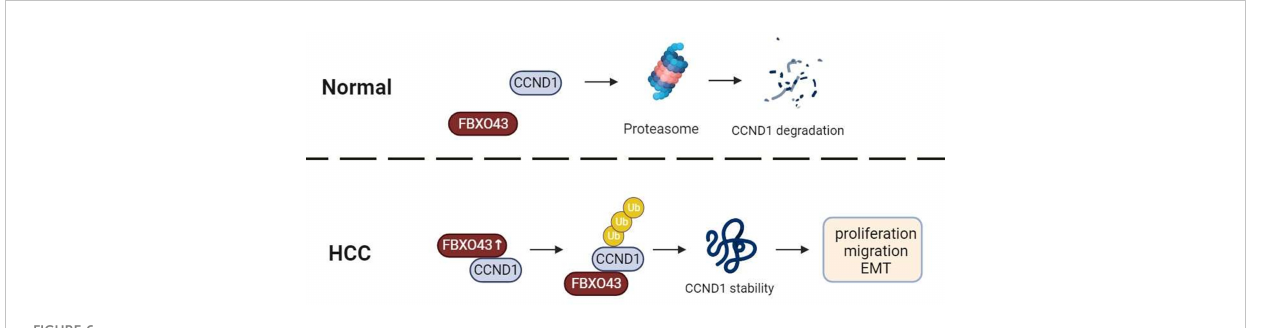
FIGURE 6 A graphical abstract of the role of FBXO43 in HCC. FBXO43 interacted with CCND1 and promoted its stability by polyubiquitination, leading to HCC cell proliferation, migration and